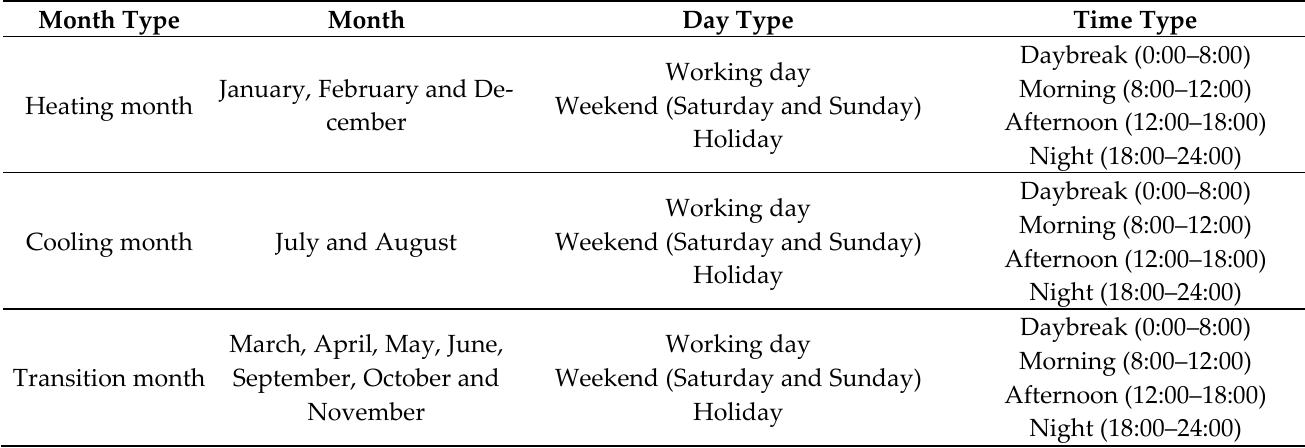
Table 2. Study time division of electricity load